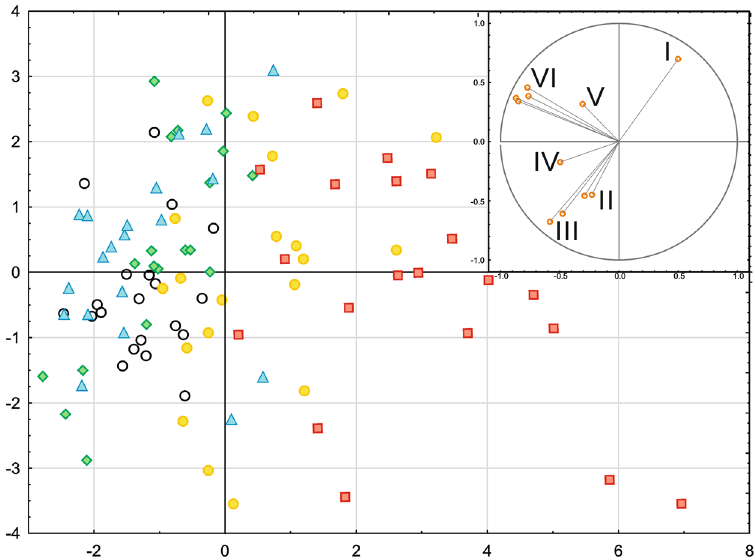
Figure 5. The Principal Component Analysis (PCA) presenting the relationships between selected photosynthetic parameters and pigment concentrations in maize under selected macronutrient deprivation. The variants are marked with points (white circle – control, green rhombus – Ca, yellow circle – K, red square – Mg, blue triangle – P,). The variables determining the distribution of the cases: I – Anthocyanin conent, II – Transpiration rate and stomatal conductance, III – Chlorophyll and flavonol content, IV – Photosynthetic rate, V - ϕ